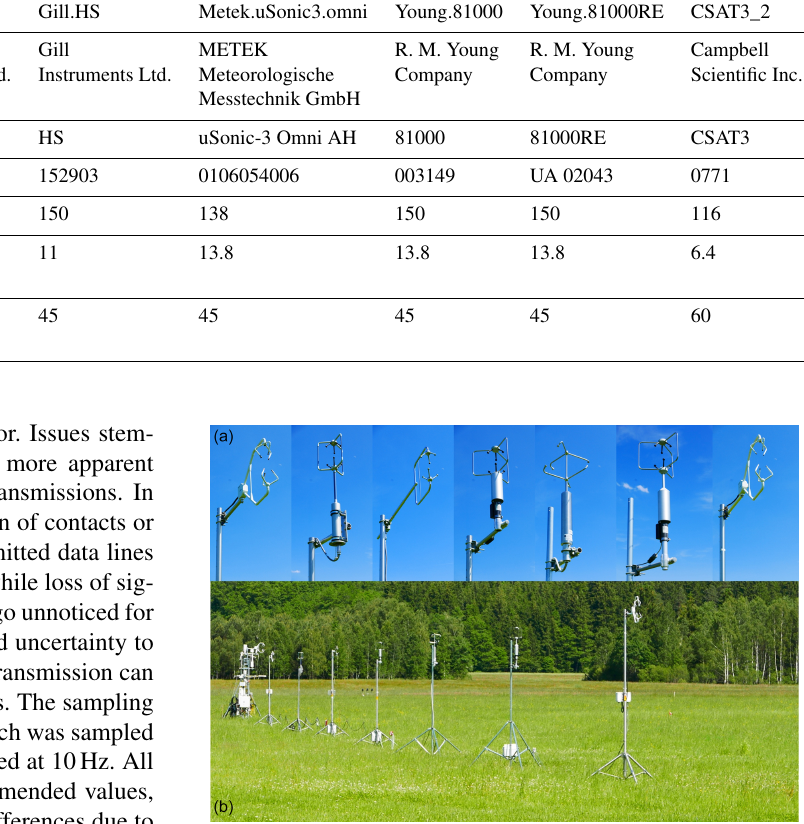
Figure 2. (a) Close-up pictures of all seven sonic anemometers; they are presented from left to right in the same order as they are listed in Table 1. (b) A photograph of the field intercom- parison experiment; the micrometeorological installations of the TERENO/ICOS site DE-Fen can be seen in the background